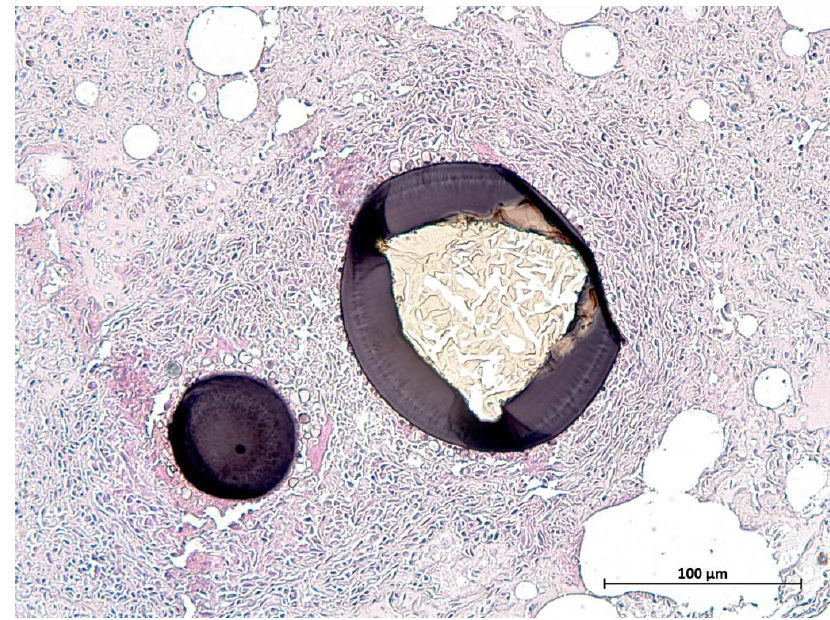
Figure 4. Fungal adiaspore in the lung tissue of an otter from Schleswig-Holstein. Pyogranulomatous pneumonia was diagnosed in one male otter (2.5–3.5 years). Non- purulent pleuritis occurred in one male (2.5–3.5 years). Another male otter had a foreign body (plant fiber) in its lung and associated severe growth of bacteria on the pleura pul- monalis, and septic spread of bacteria was assumed. A female otter (0.6–1.7 years) showed non suppurative bronchiolitis. Hemorrhages only occurred in animals that died as road- kill, and were therefore attributed to blunt trauma. 3.3.3. Cardiovascular System Fibrosis of the myocardium, together with severe loss of cells and focal metaplastic bone development were seen in one male otter (3.5–5.5 years). Protozoal cysts were found in one female (1.3–2.25 years) and one male (1–2 years) otter. 3.3.4. Thoracic Cavity A male otter (2.5–3.5 years) displayed nonpurulent serositis (diaphragm) and was also affected by pneumonia (nonpurulent and granulomatous) and pleuritis. In a third male (1.5–3.5 years), an interstitial edema was found in the diaphragm. Protozoal cysts in the diaphragm were present in four female (~0.5–3.5 years) and four male (~0.5–5.5 years) otters (see also 3.6 Parasitology).